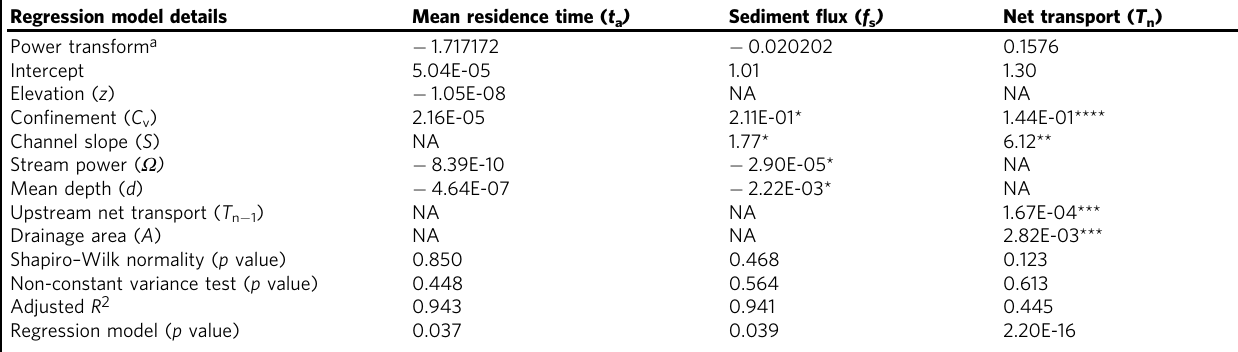
Table 2 Multiple linear regression models Regression model details Power transform